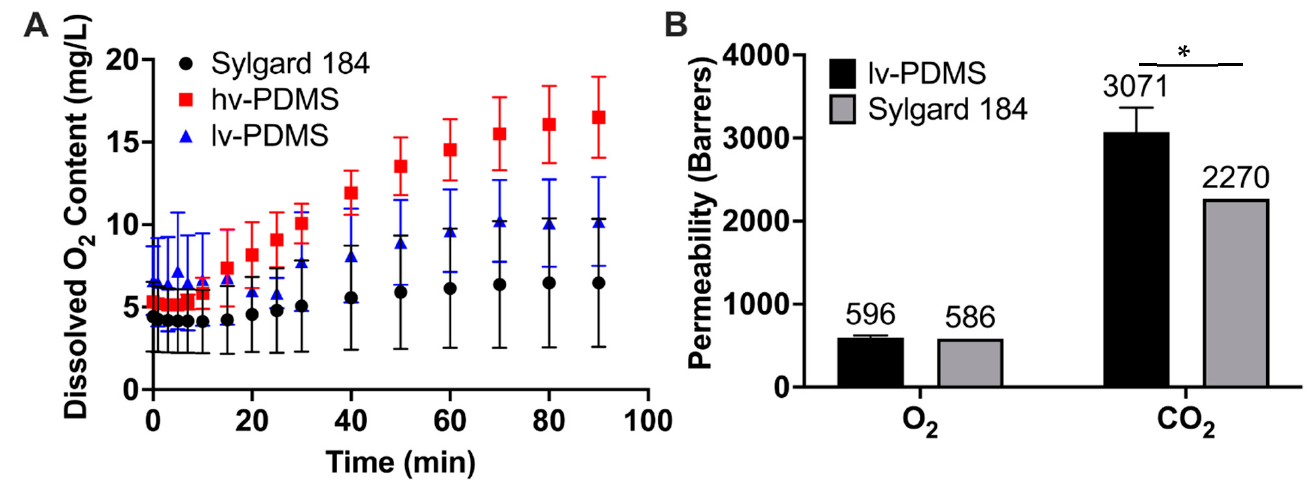
Figure 4. ( A ) Dissolved O 2 measurements demonstrating gas permeability of the cured resins, lv-PDMS and hv-PDMS, relative to Sylgard 184. Error bars represent standard deviation ( n = 3). A dose–response regression of the curves showed that the total oxygen content (top plateau) between all groups was statistically significant ( p < 0.0001). ( B ) Gas permeability measurements taken at Labthink International Inc. of 150 µm film made from lv-PDMS resin. Error bars represent standard deviation ( n = 3). O 2 standard deviation is 28 Barrers, and CO 2 standard deviation is 295 Barrers. Sylgard 184 data were taken from the literature [28]. A one-sample t-test comparing lv-PDMS with Sylgard 184 determined there was not a significant difference for O 2 but there was for CO 2 (* indicates p < 0.05).